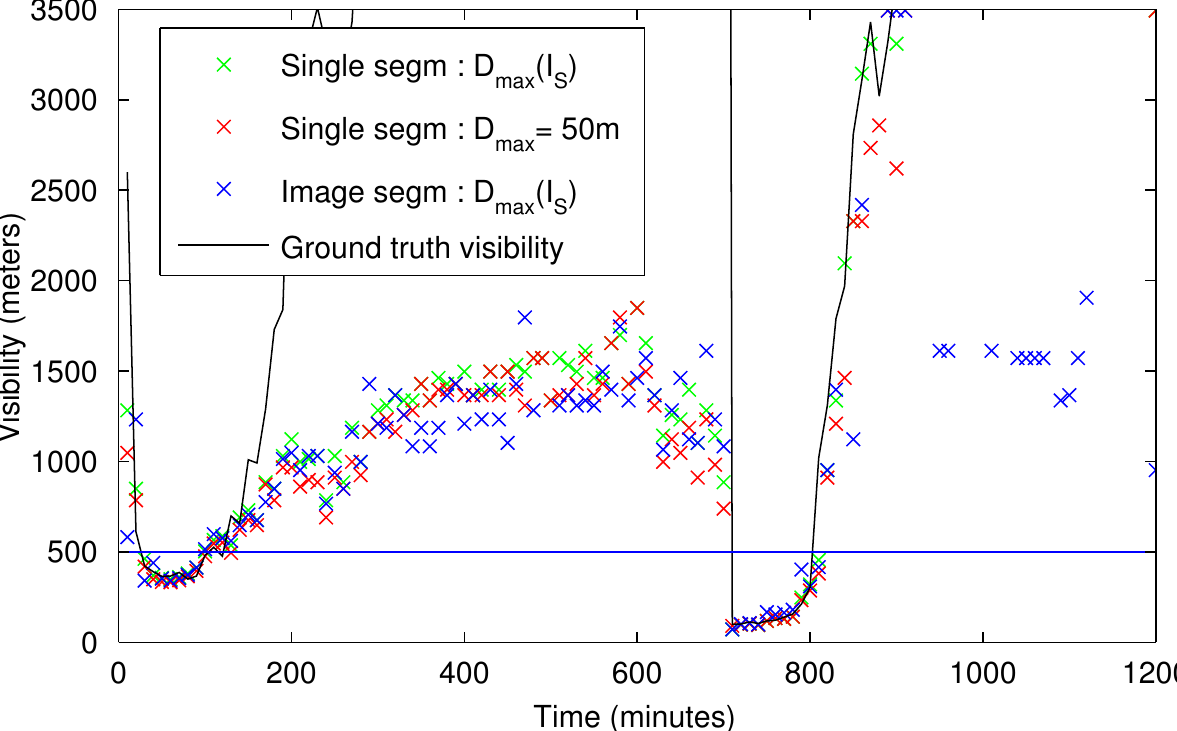
Figure 4: Comparison between estimated visibility distance and ground-truth during 1600 minutes (one image every 10 minutes, images during the night are skipped) on the Matilda database. The proposed method is tested with two depth ranges: maximum distance where I S is obtained (green crosses) and a fixed range [0 , 50] m (red crosses), using a single image segmentation and is also shown the case with a different segmentation at every image (blue crosses). The ground-truth value is shown as a black line. The horizontal blue line shows the 500 m visibility distance which is considered as the distance were fog is no more considered in driving situations.